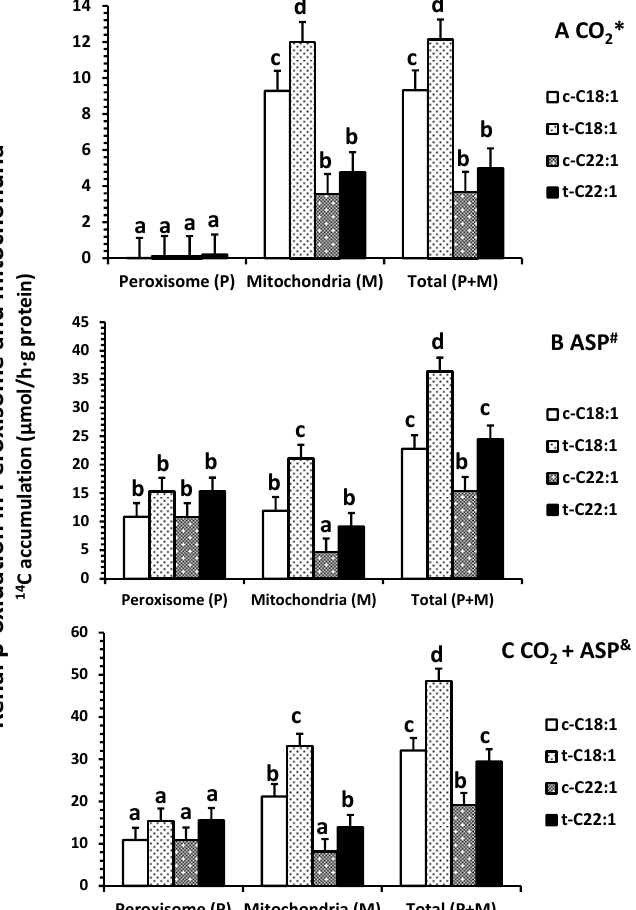
Figure 2. Effects of oral clofibrate on renal β -oxidation ( 14 C accumulation in CO 2 * ( A ); ASP # ( B ) and CO 2 + ASP & ( C )) in peroxisomes and mitochondria of neonatal pigs. Values are least square means ± SEM ( n = 5). Abbreviations: ASP: acid soluble product; c-C18:1: control with oleate; t-C18:1: treatment with oleate; c-C22:1: control with erucate; t-C22:1: treatment with erucate. * Clofibrate effect ( p < 0.037) and fatty acid effect ( p < 0.0001); # Clofibrate effect ( p < 0.0001) and fatty acid effect ( p < 0.0001); & Clofibrate effect ( p < 0.0001) and fatty acid effect ( p < 0.0001). Column with different letters differ ( p < 0.05).